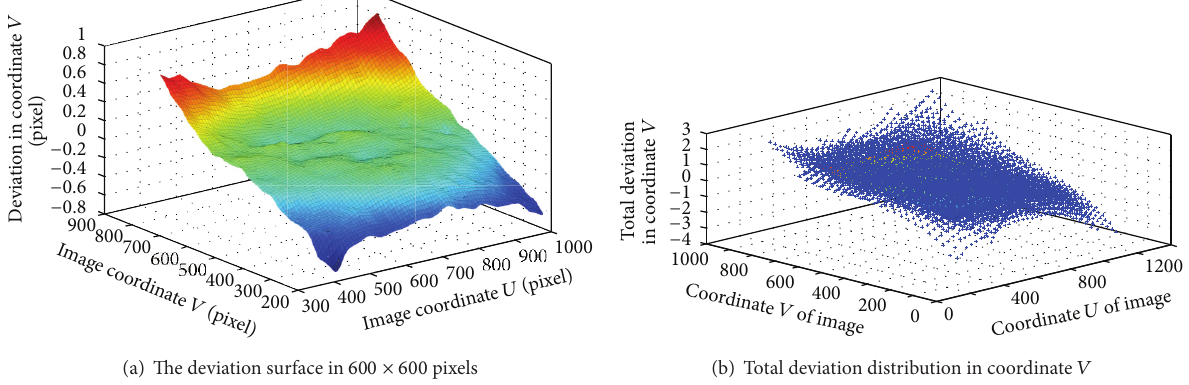
Figure 5: Deviation surface in coordinate 𝑉 of the image.